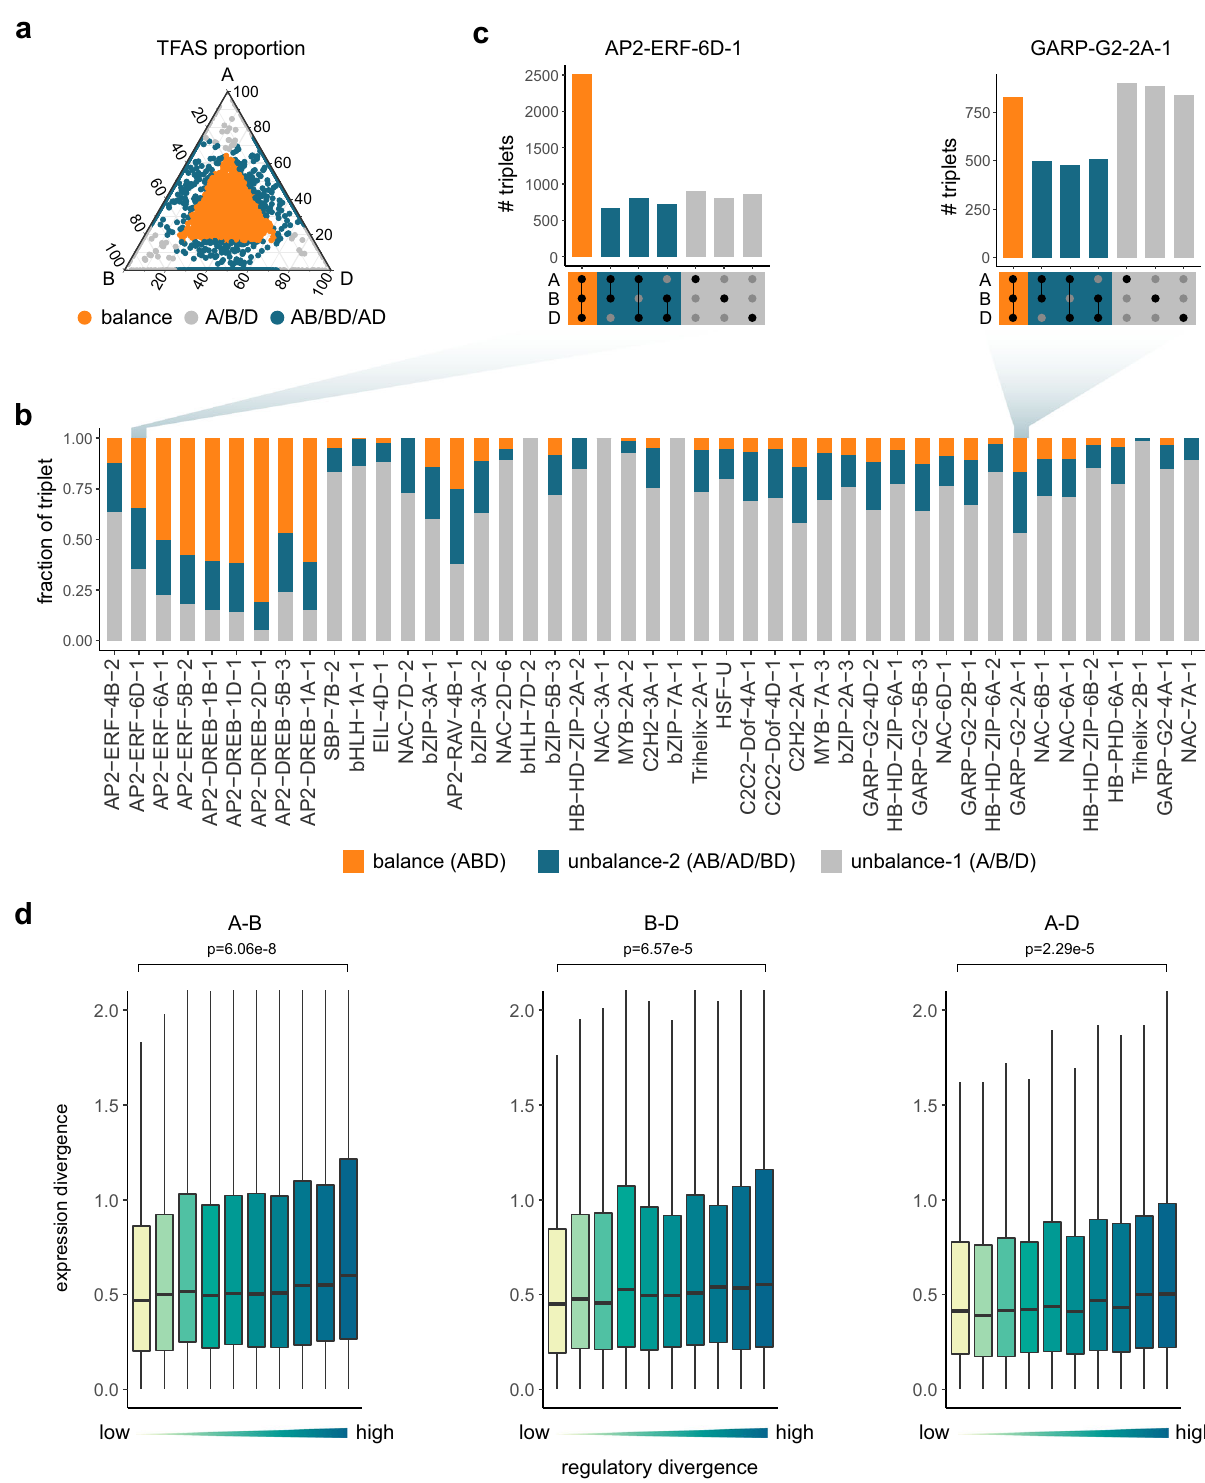
Fig. 5 | Quantitative association between subgenome-biased TF binding and expression. a Illustration of the quantitative divergence of TF binding in the pro- moters of triad genes. The relative binding of AP2-ERF-6D-1 is presented. Orange dots represent the balanced regulatory pattern. Blue and gray dots represent the unbalanced regulatory pattern. b Fraction of balanced and unbalanced TF binding in the promoters of triad genes (1:1:1 correspondence across subgenomes). c Bar plot presenting the results of the quantitative analysis of the balanced and unba- lanced binding ofAP2-ERF-6D-1 and NAC-6A-1. d Correlation of subgenome-biased binding and expression. Homoeologous gene pairswere grouped according to the